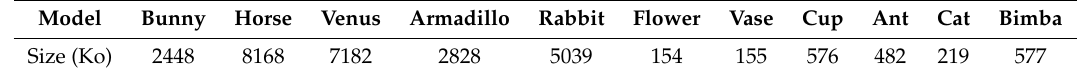
Table 1. Size of the 3D models used in the